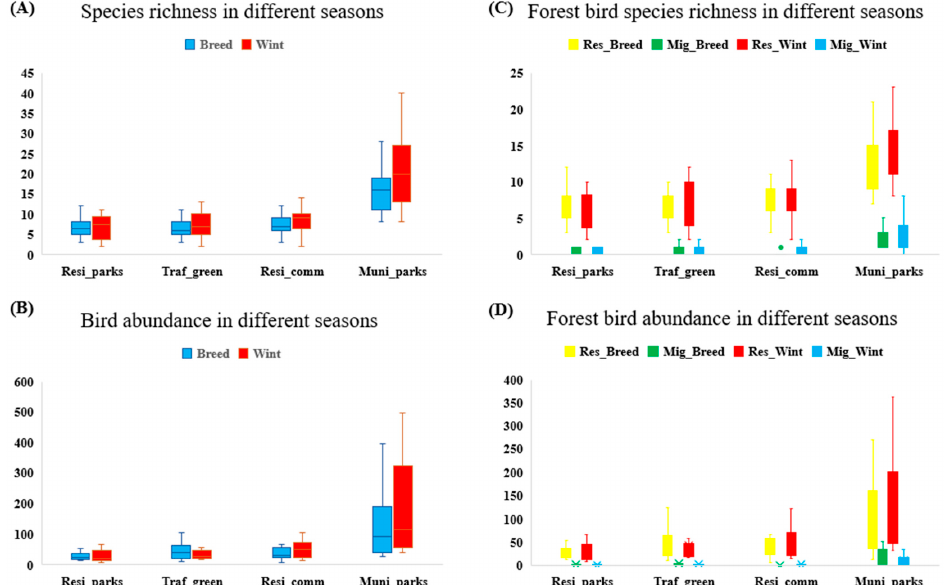
Figure 5. Box plots for species richness and abundance of different bird guilds in different habitat types. “Breed” represents breeding season, “Wint” represents wintering season, “Res” represents resident birds, “Mig” represents migrants.